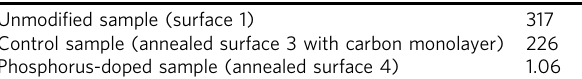
Table 1 Sheet resistances of silicon samples via SAMM doping technique by van der Pauw measurement Si(100) intrinsic wafer, resistivity > 10 k Ω cm R s Unmodi fi ed sample (surface 1) 317 Control sample (annealed surface 3 with carbon monolayer) 226 Phosphorus-doped sample (annealed surface 4)